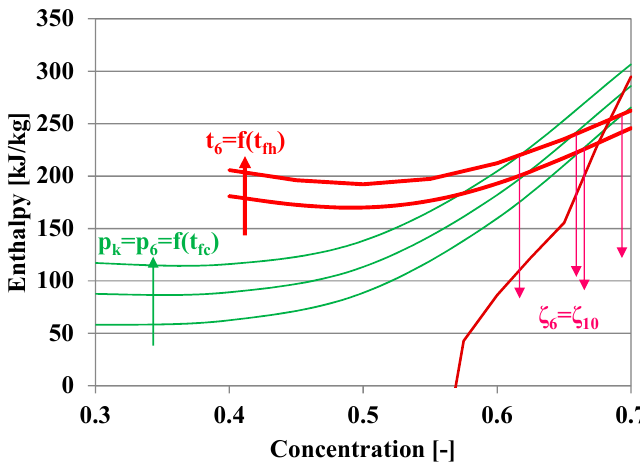
Figure 10. Influence of different parameters on the risk of crystallization.